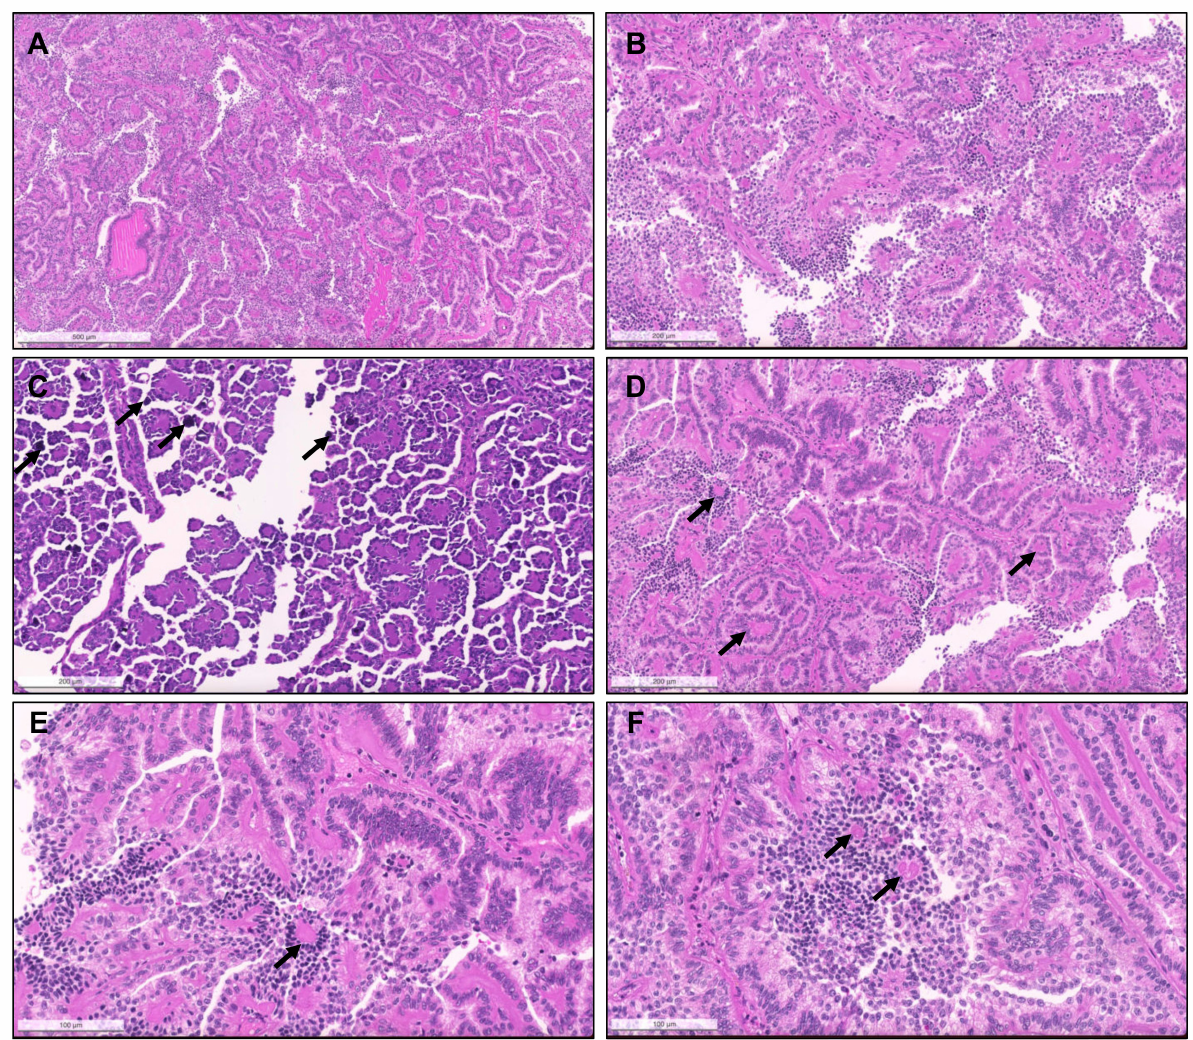
Figure 6. Biphasic hyalinizing psammomatous RCC. The biphasic nature of the tumor can already be seen at a low power ( A ). The tumor is composed of a population of small cells with small hyperchromatic nuclei, intermingled between and around a second population of larger cells. There is deposition of an eosinophilic basement membrane material ( B ). In some cases, the small cells were the predominant population, distributing around hyalinized papillae cores. Several small psammomatous calcifications were observed (( C ), arrows). The larger cells cover the papillary fronds, and the smaller cells are tendentially distributed around basement membrane material, sometimes producing the aspect of pseudo-rosettes (( D – F ),